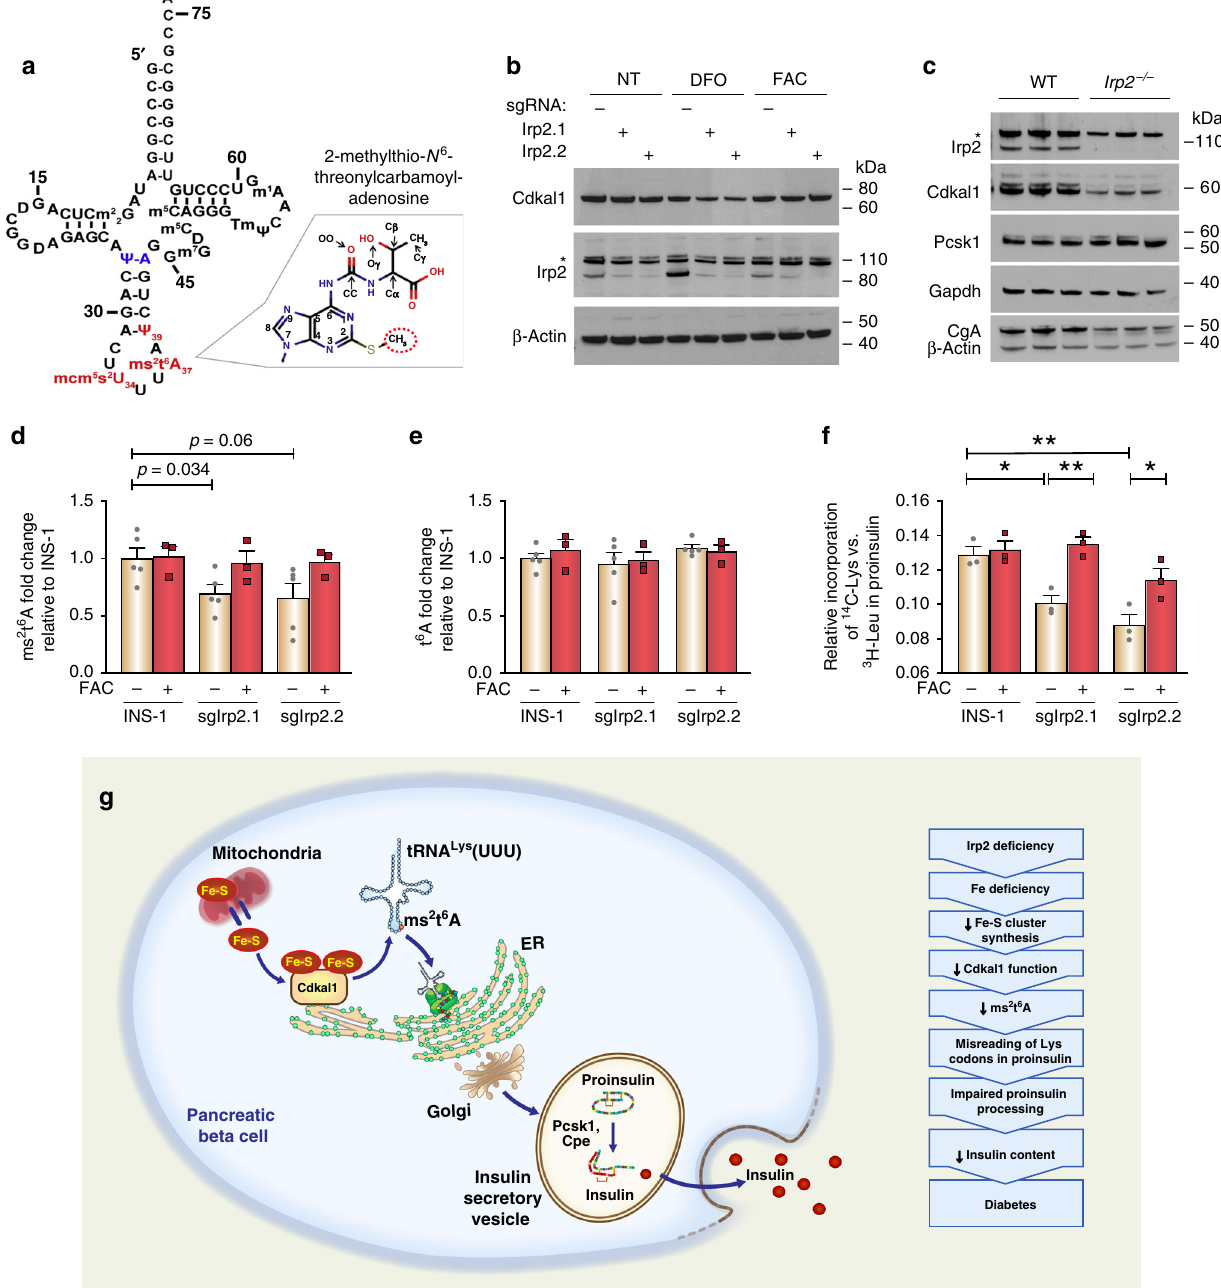
Fig. 8 Irp2 de fi ciency reduces the ms 2 t 6 A modi fi cation in tRNA Lys UUU causing misreading of lysine codons in proinsulin. a Secondary structure and sequence of tRNA Lys UUU with anticodon loop modi fi cations 2-methylthio-N 6 -threonylcarbamoyl adenosine (ms 2 t 6 A37), methoxycarbonylmethyl-2- thiouridine (mcm 5 s 2 U34) and pseudouridine-39 ( ψ − 39). The ms 2 group on ms 2 t 6 A37 is indicated by a dotted circle. Adapted from Vendeix, et al. 68 . b Western blot analysis of Cdkal1 in control, sgIrp2.1, and sgIrp2.2 INS-1 cells grown in medium with or without DFO or FAC for 18 h. β -Actin is a loading control. Asterisk, nonspeci fi c band. c Western blot analysis of Irp2, Cdkal1, Pcsk1, and CgA in islets isolated from 6-month old WT and Irp2 − / − mice. Gapdh is a loading control for Irp2, Cdkal1 and Pcsk1 and β -actin is a loading control for CgA ( n = 3 mice per genotype). d – e LC-MS analysis of ms 2 t 6 A ( d ) and t 6 A ( e ) modi fi cations in control, sgIrp2.1, and sgIrp2.2 INS-1 cells grown in medium with or without supplemental FAC for 18 h ( n ≥ 3 independent biological experiments). f Relative incorporation of 14 C-lysine versus 3 H-leucine in proinsulin immunoprecipitated from control, sgIrp2.1, and sgIrp2.2 INS-1 cells grown in medium with or without supplemental FAC ( n = 3 independent biological experiments). Data in d , e are expressed as means ± s.e.m., unpaired two-tailed Student ’ s t test, * p < 0.05, ** p < 0.01 relative to control INS-1 cells; data in f are expressed as means ± s.e.m., compared by one-way ANOVA with Tukey ’ s multiple comparison test, * p < 0.05, ** p < 0.01. g Model of Irp2 regulation of proinsulin processing and insulin secretion in β cells. Source data are provided as a Source Data fi